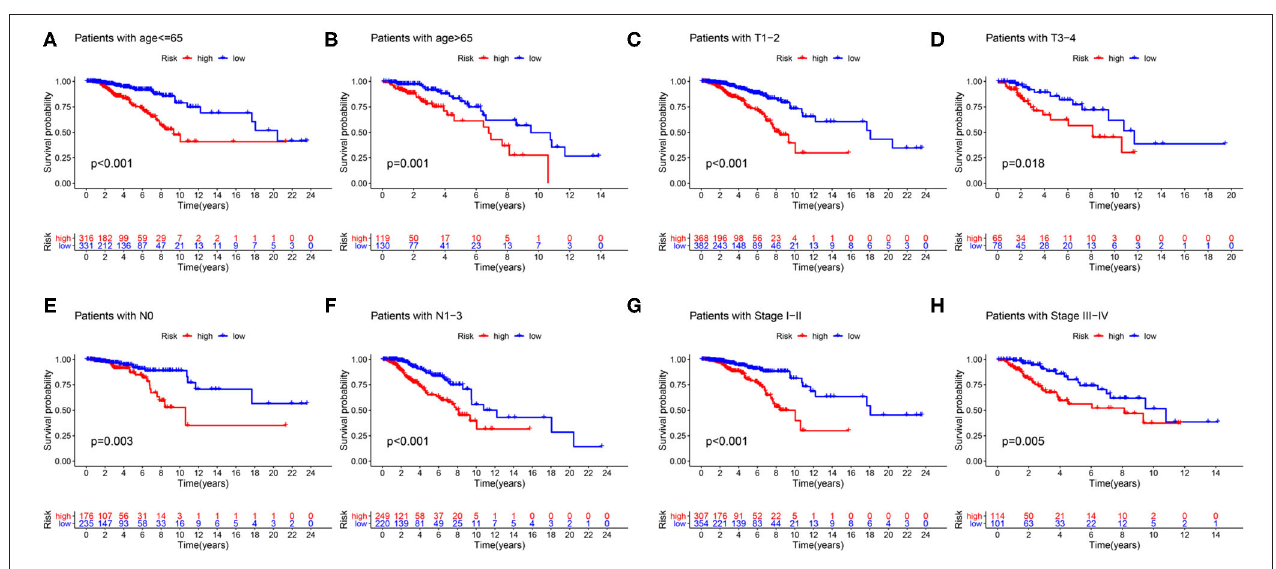
FIGURE 12 | Validation of the risk score prognostic model among the different clinical groups. (A) Age ≤ 65; (B) age > 65; (C) T1-2; (D) T3-4; (E) N0; (F) N1–3; (G) stage I–II; (H) stage III–IV. The blue lines represent the low-risk groups, the red lines represent the high-risk groups.